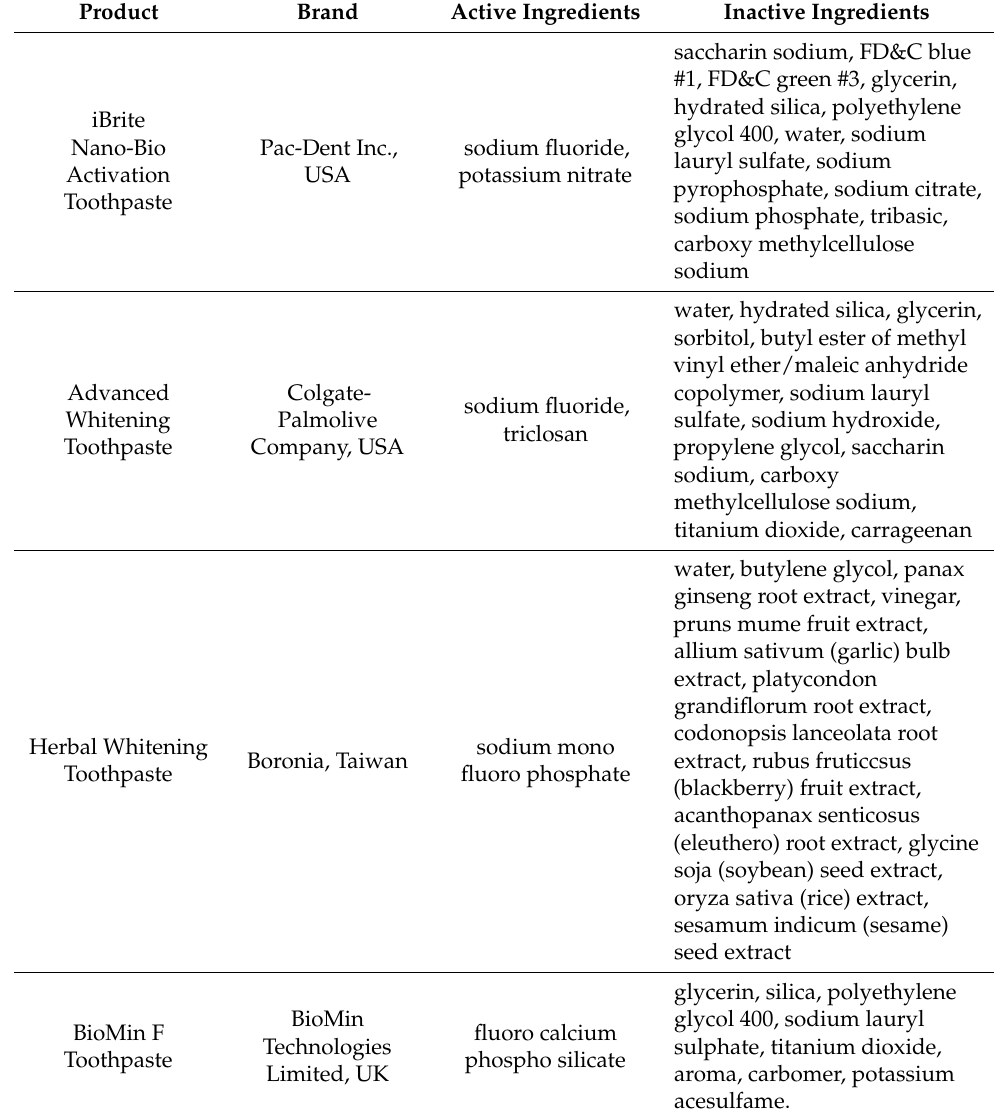
Table 1. The ingredients of the investigated